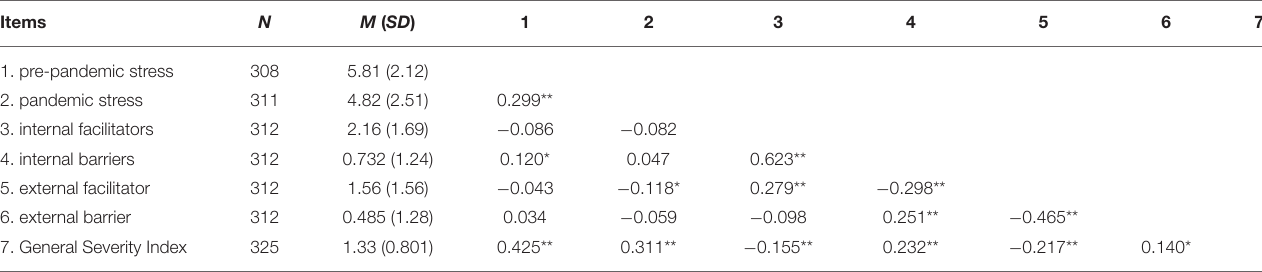
TABLE 3 | Spearman rho correlation analysis for components of the stress barometer and the general-severity-index (GSI).